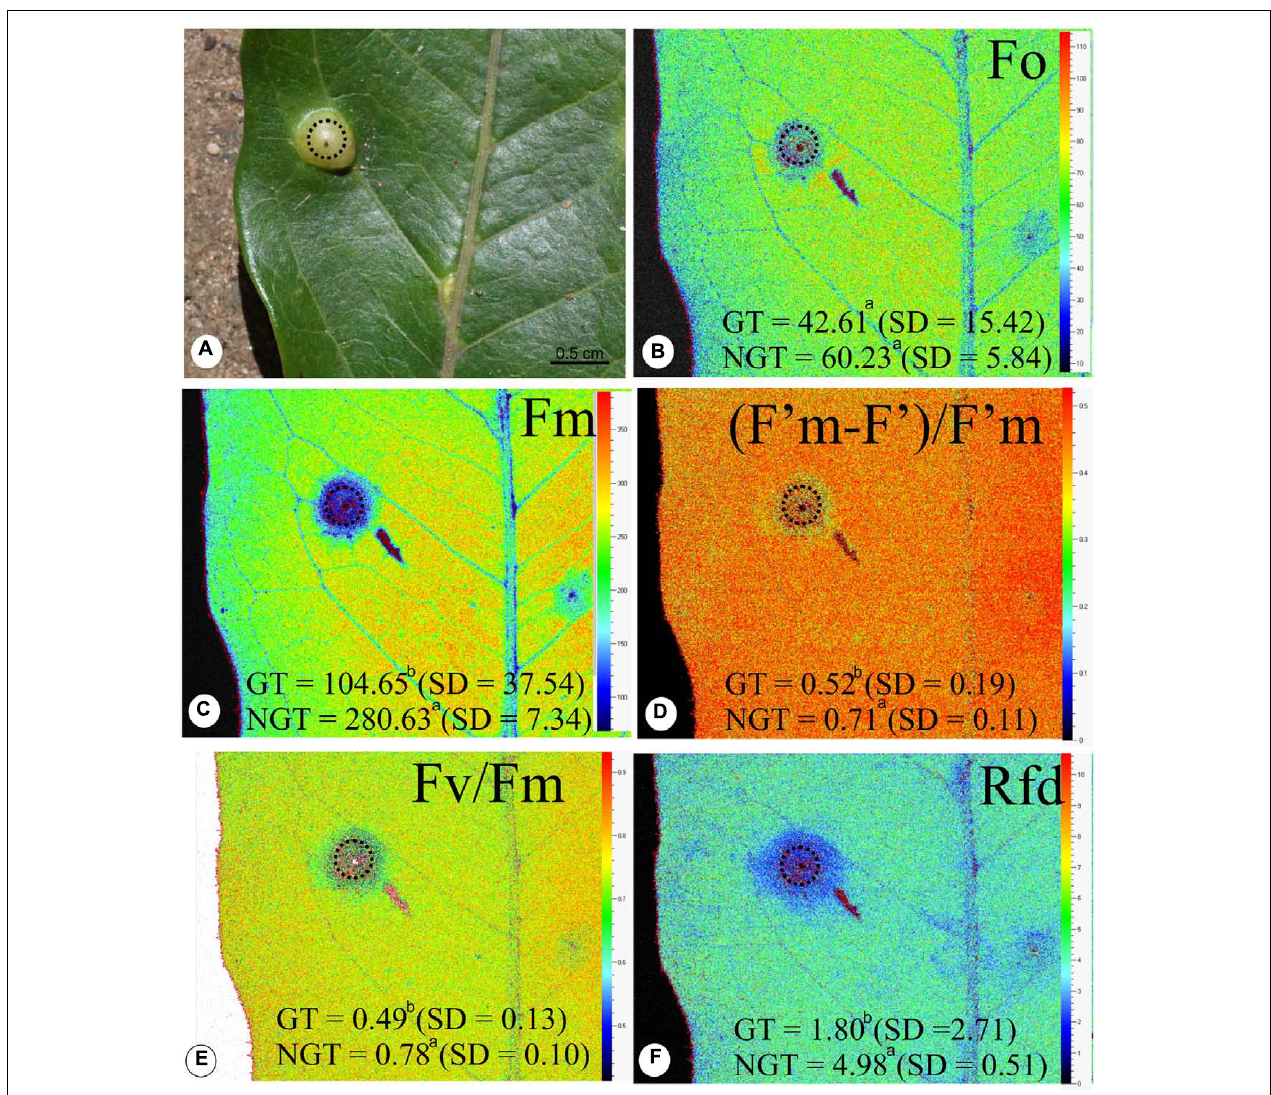
FIGURE 3 | Fluorescence quenching analysis performed (means ± standard deviation) in non-galled tissues of Matayba guianensis (Sapindaceae) and in galls induced by Bystracoccus mataybae (Eriococcidae) using a modulated fluorescence imaging apparatus (Handy Fluorcam PSI – Photo Systems Instrument, Czech Republic). (A) Leaflet with a gall (doted circle). (B) Imaging of F 0 (minimum fluorescence of PSII in dark-adapted state). (C) Imaging of Fm (maximum fluorescence of PSII in dark-adapted state). (D) Imaging of ( F ’m– F ’)/ F ’m (PSII operating efficiency). (E) Imaging of F v/ F m (maximum PSII quantum yield in dark-adapted state). (F) Imaging of Rfd (instantaneous fluorescence decline ratio in light). GT, galled tissue; NGT, non-galled tissue, SD, standard deviation. Values followed by the different letters differ significantly by the Wilcoxon